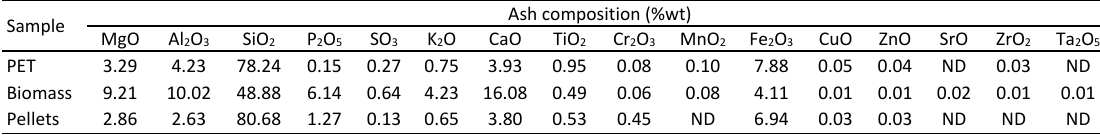
Table 5: Composition of the different ash samples